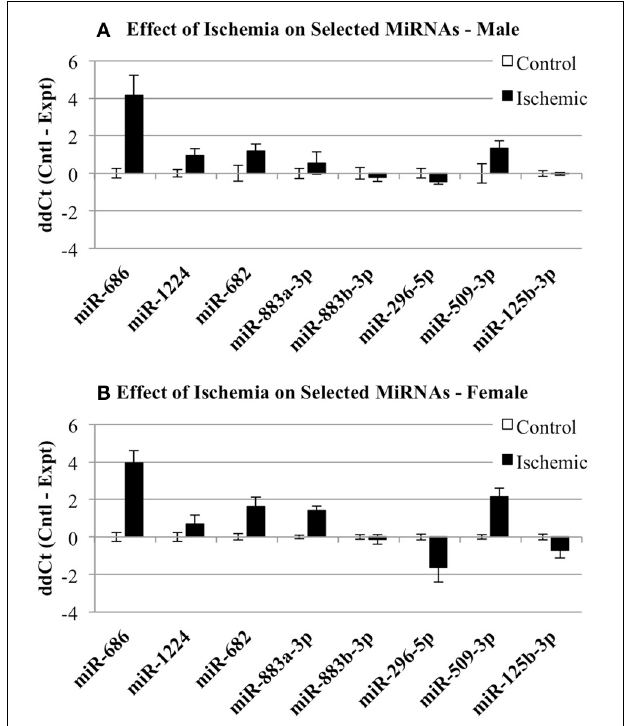
FIGURE 3 | Effect of treatment on miRNAs identified as non-changers in male and female mouse cortex. The graphs illustrate that miR-15b ∗ and miR-125b-3p were not changed significantly in any treatment group in male (A) or female (B) mouse cortex. Control (white bar), sham (gray bar), ischemia (black bar).